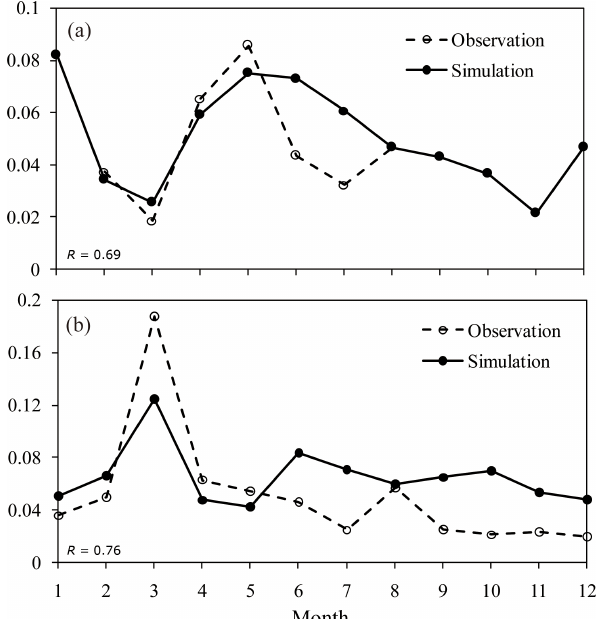
Figure 5. Comparison between the AERONET-observed monthly mean aerosol AOD (500nm) at Nam Co and simulated by the con- trol experiment at the grid near Nam Co in (a) 2007 and (b) 2009.